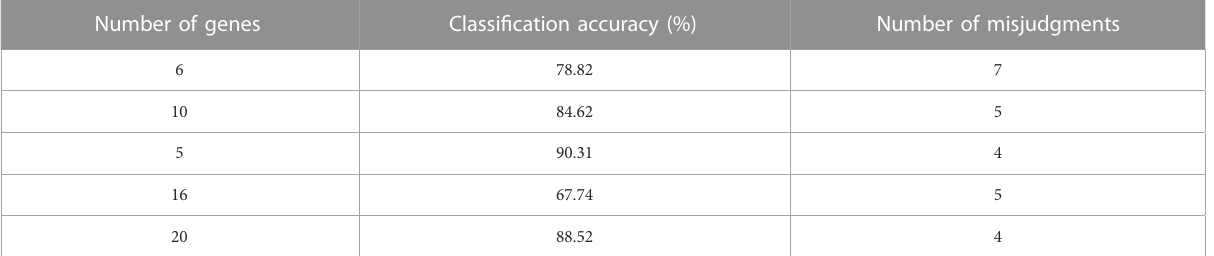
TABLE 4 Detection results of signature